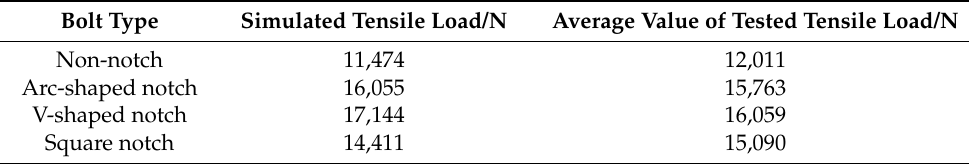
Table 5. Comparison of simulation and test results for different notch structures.